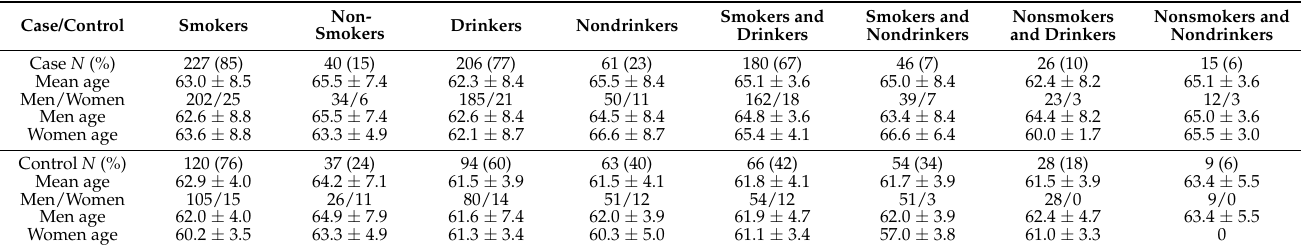
Table 2. Age and sex distribution in laryngeal cancer case group and control